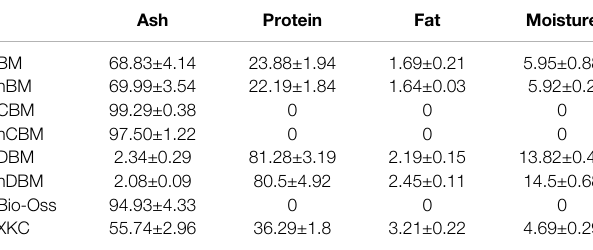
TABLE 1 | Basic component content of different bone powders (%).